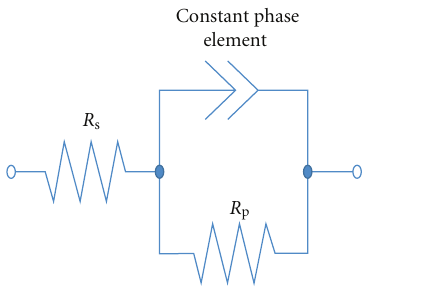
Figure 9: An equivalent circuit for analysis of TiO 2 electrodes in DSCs. Table 2: Electrochemical impedance components from Figure